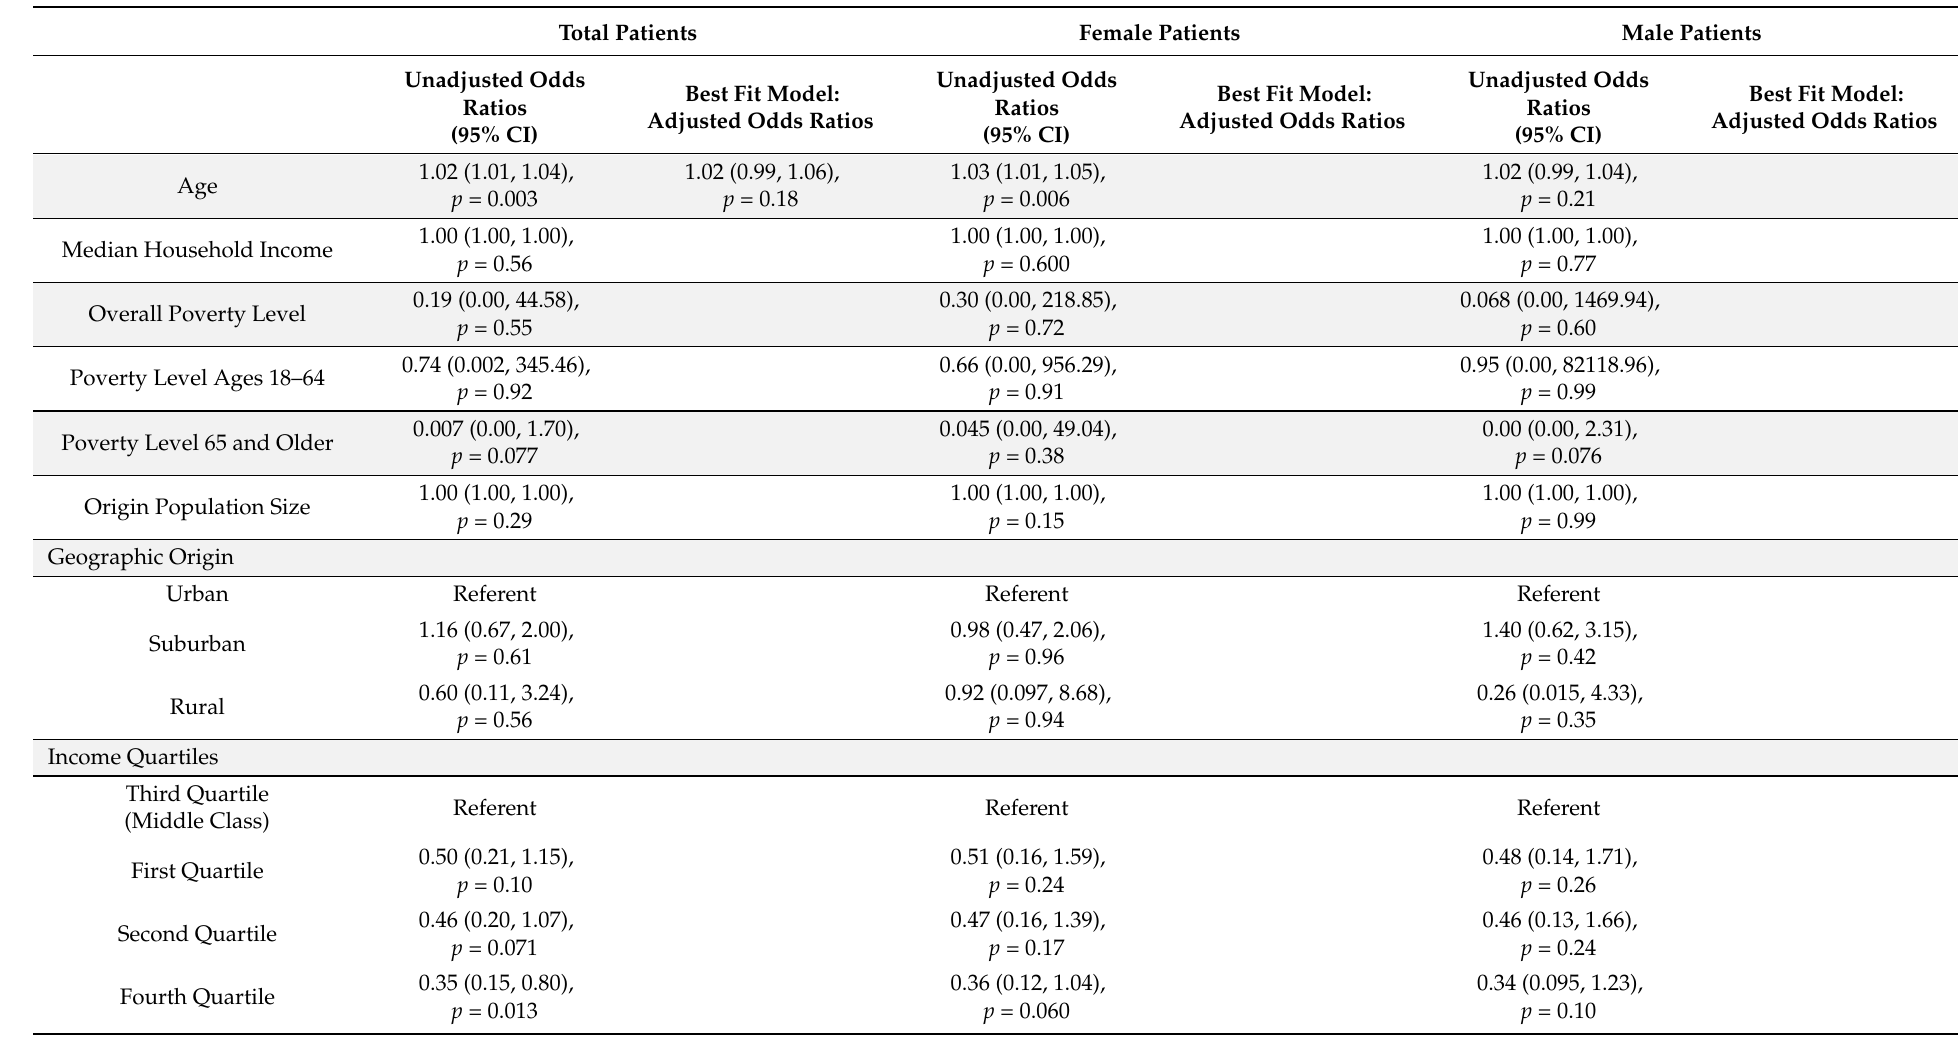
Table 8. Univariate and multivariable analysis of variables associated with vaccine hesitancy for all patients with neurological disorders and patients stratified by sex. Total Patients Female Patients Male Patients Unadjusted Odds Unadjusted Odds Unadjusted Odds Best Fit Model: Best Fit Model: Best Fit Model: Ratios Ratios Ratios Adjusted Odds Ratios Adjusted Odds Ratios Adjusted Odds (95% CI) (95% CI) (95% CI)